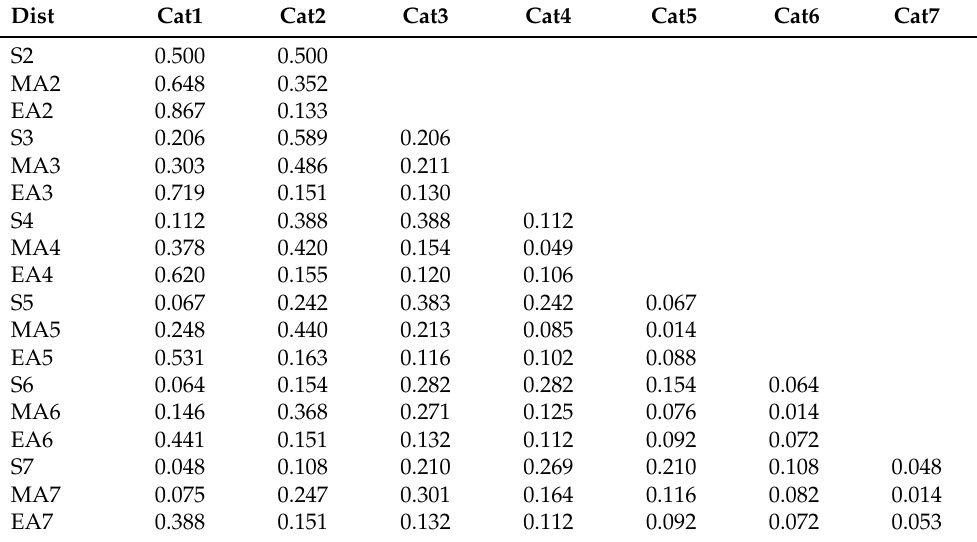
Table A1. Data-generating parameters for marginal distributions of items (i.e., item-category proba- bilities P ( Y i = h ) for h = 1, . . . , K i